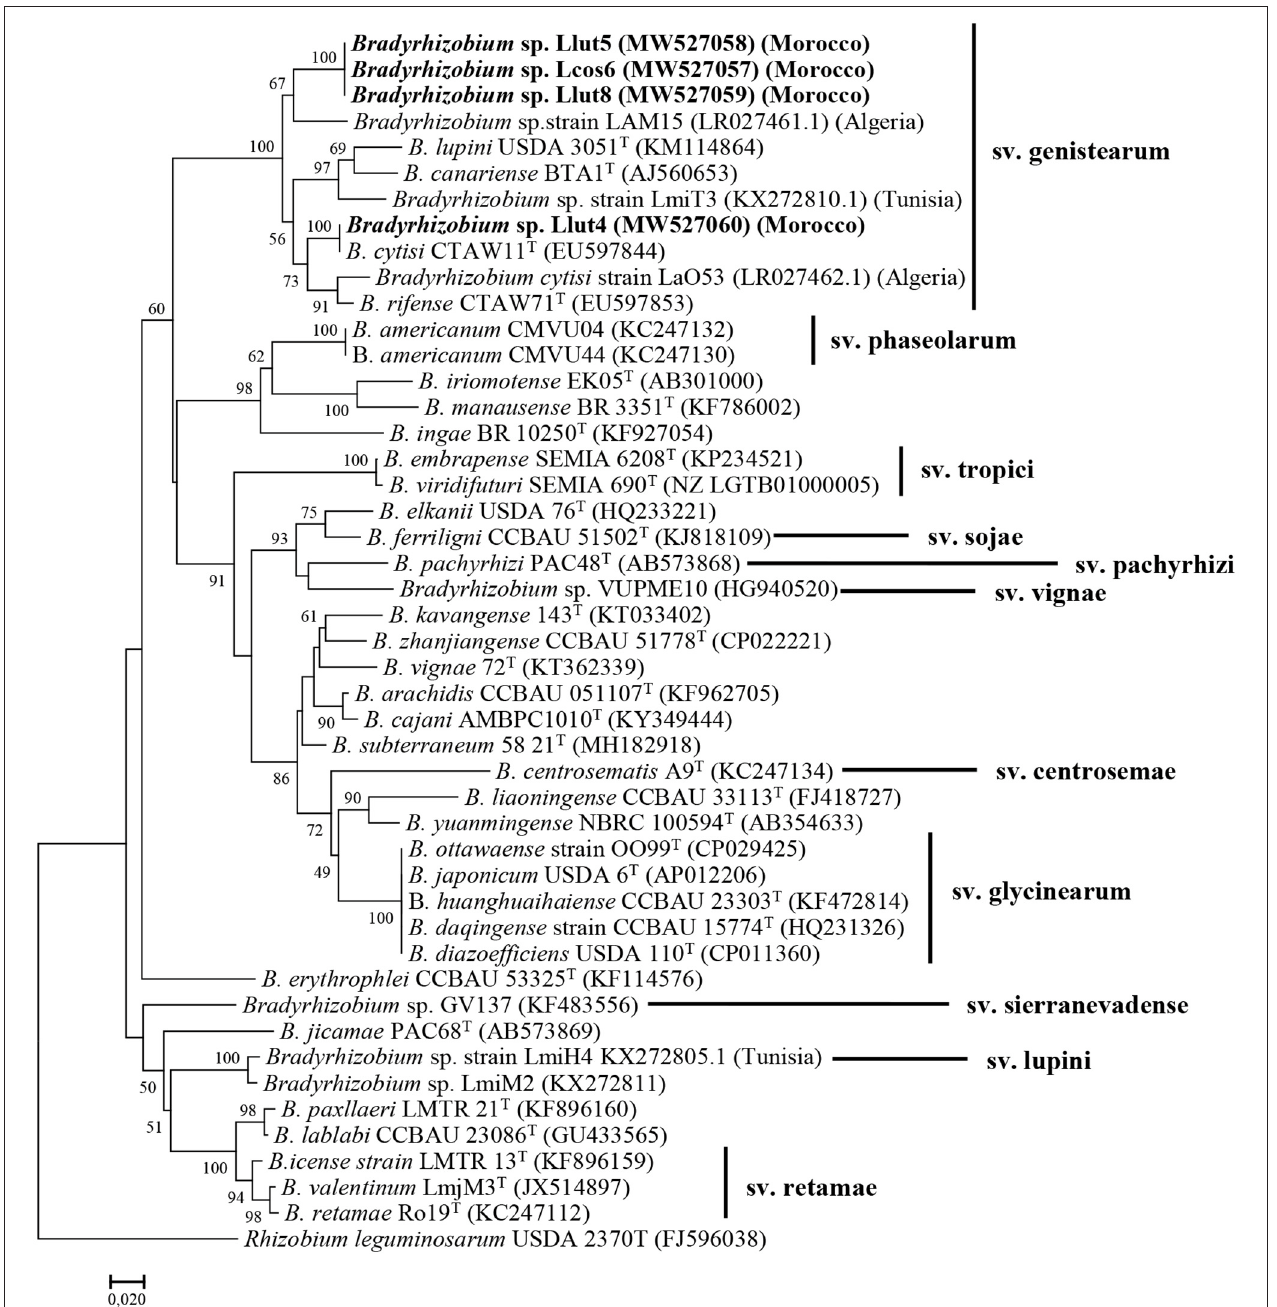
FIGURE 3 | Maximum likelihood phylogenetic tree based on concatenation of the nodC gene partial sequences of the strains Lut4, Llut5, Lcos6, and Llut8, isolated from nodules of L. cosentinii and L. luteus and related species within the genus Bradyrhizobium . Isolates are denoted in bold. Bootstrap values are indicated as percentages derived from 1000 replications. Values lower than 50 are not shown. Bar, 2 nucleotide substitution per 100 nucleotides. The original geographical origin of the species is shown in brackets. The tree is rooted with R. leguminosarum USDA 2370 T